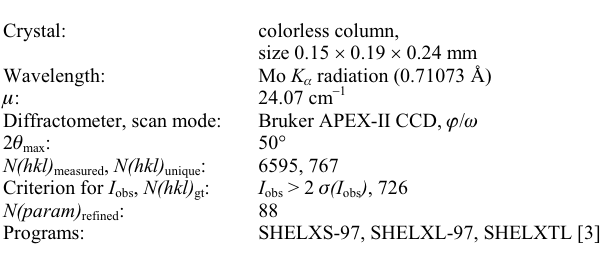
Table 1. Data collection and handling.